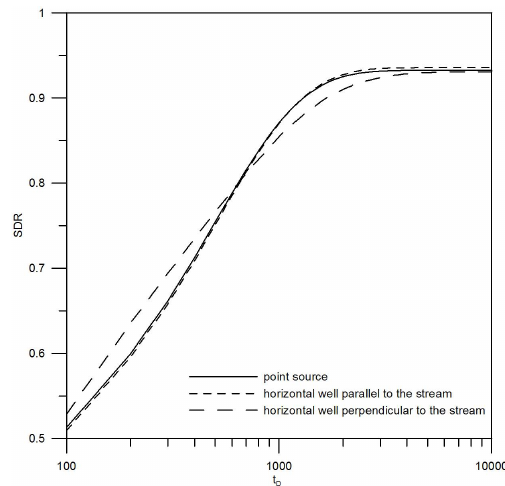
Fig. 3. The SDR from the horizontal well parallel to the stream versus dimensionless time for κ y = 1, κ z = 1, L D = 1, and various distance between the well and stream.